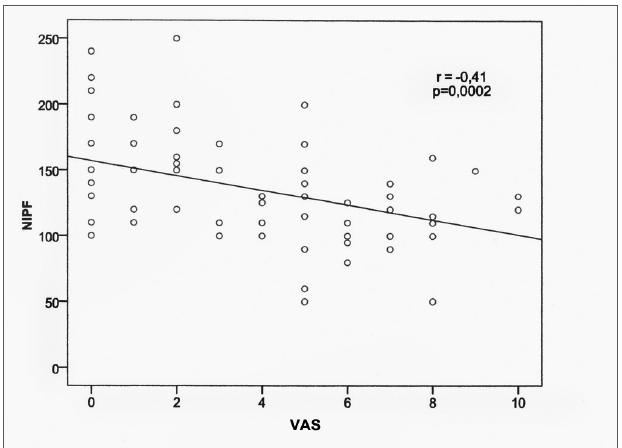
Graph 1. Correlation between the NIPF and the Visual Analogue Scale